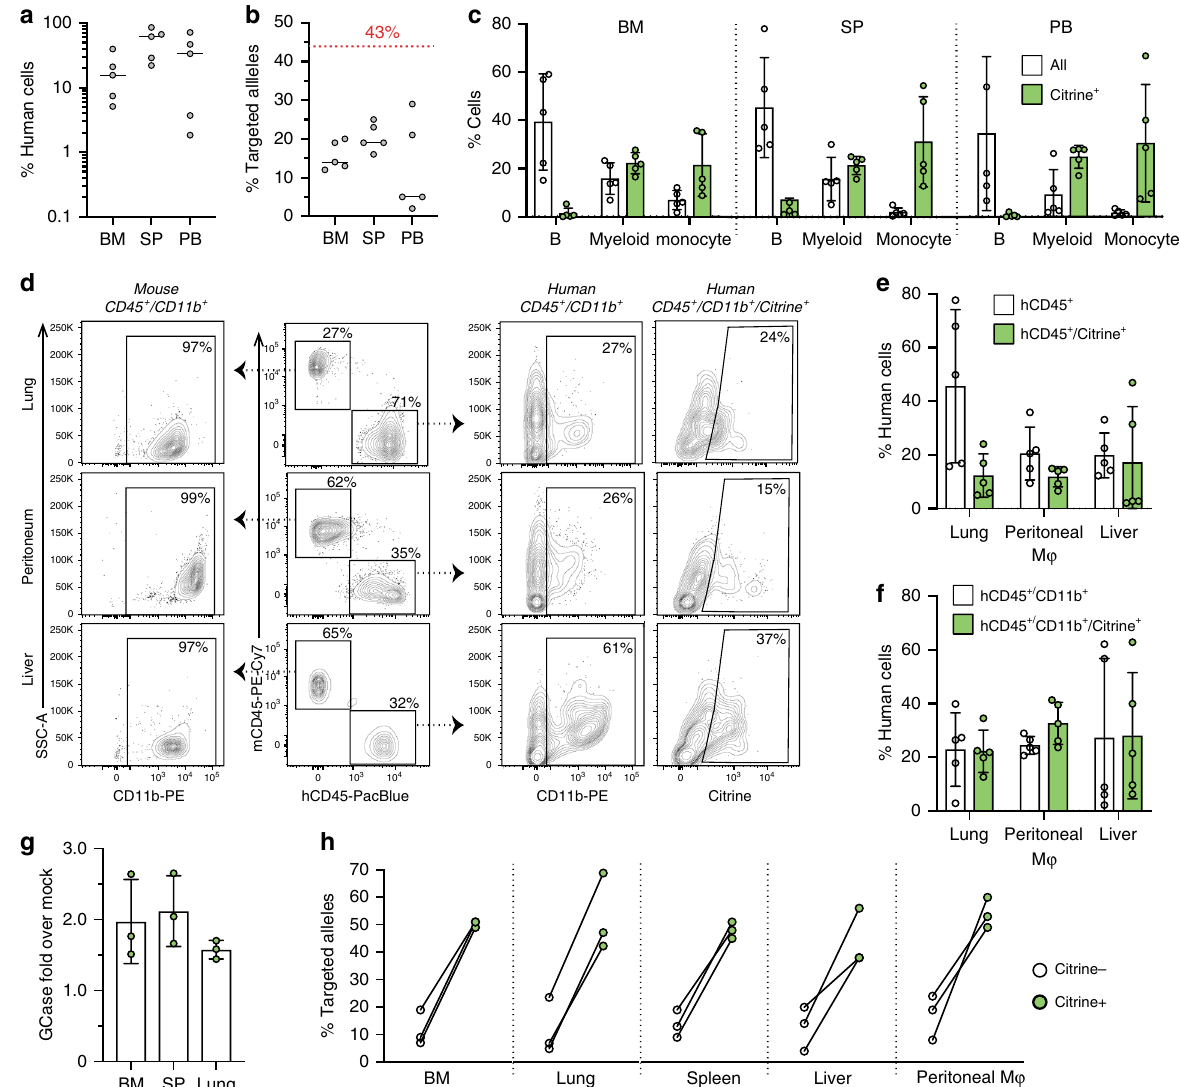
Fig. 6 Improved macrophage differentiation of GCase-targeted HSPCs in NSG-SGM3 mice. a Human cell engraftment 16-weeks post-transplantation in the bone marrow (BM), spleen (SP), and peripheral blood (PB) in transplants using CD68S-GCase-P2A-Citrine-targeted cells ( n = 5 mice). b Modi fi ed allele frequency from engrafted CD68S-GCase-P2A-Citrine-targeted cells in the same tissues ( n = 5 mice). c Percent human B-cell (CD19 + ), myeloid (CD33 + ), and monocyte (CD14 + ) populations in BM, SP, and PB shown in white. Citrine-positive cells in each population are shown in green ( n = 5 mice). d Representative FACS plots showing gating strategy for mouse and human CD45 + , CD45 + /CD11b + , and CD45 + /CD11b + /Citrine populations in macrophage preparations from lung, peritoneum, and liver. e Percent human CD45 + and human CD45 + /Citrine cells in the same preparations ( n = 5 mice). f Percent human CD45 + /CD11b + and human CD45 + /CD11b + /Citrine cells in the same preparations ( n = 5 mice). g Fold GCase activity in human Citrine + cells compared to human Citrine − cells in BM, SP, and lung ( n = 3 mice). h Modi fi ed allele frequency in human Citrine + cells (green) compared to human Citrine − cells (white) in BM, SP, and lung in the same cells. a , b Median shown. c , e – g Data shown as mean±SD. Source data are provided as a Source Data fi